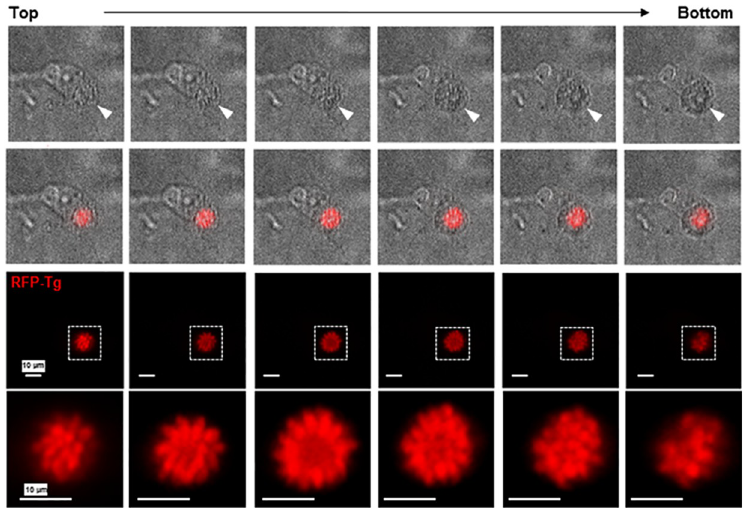
Fig 4. Organization of the parasites in PV within VERO cells in 3D collagen matrix. Microscopy observation at 40x of a live VERO cell infected with RFP-expressing Toxoplasma and cultivated in a 3D collagen matrix for 24 h (XY views). Upper panels show bright field images, with arrowheads pinpointing the PV, lower panels illustrate RFP- parasites by fluorescence, and middle panels are overlay images. Insets show the PV at 3.5x magnification. Images were taken every 1 μ m in depth and reveal symmetrical organization of intravacuolar Toxoplasma , comparable to rosette- like structures formed by parasites within a PV.